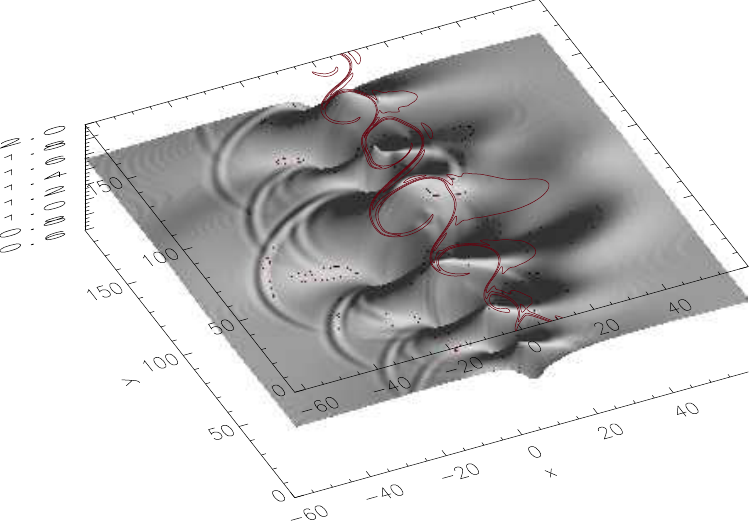
Figure 1. Total pressure P T (gray color) in the ( x , y ) -plane with overplotted density isocontour lines (red color) at t = 146 for the case V 0 = 3. The density isocontour evidences the shape of the vortices in the middle of the box and the pressure perturbations put in evidence the emission of fast waves from the shear layer.